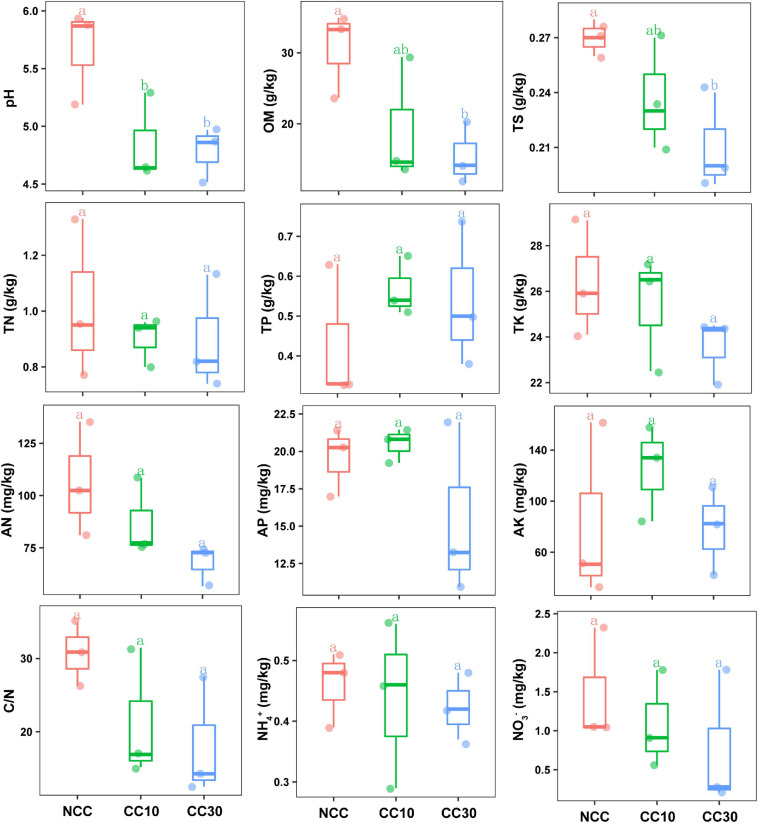
Effect of continuous sugarcane cropping on basic soil properties and nutrient contents. Boxes with the same lowercase letters indicate no significant difference between treatments based on the LSD test (P < 0.05). OM, organic matter; TN, total nitrogen; TS, total sulfur; TK, total potassium; TP, total phosphorus; AN, available nitrogen; AP, available phosphorus; AK, available potassium; NCC, no continuous cropping history; CC10, 10 years of continuous cropping; CC30, 30 years of continuous cropping.